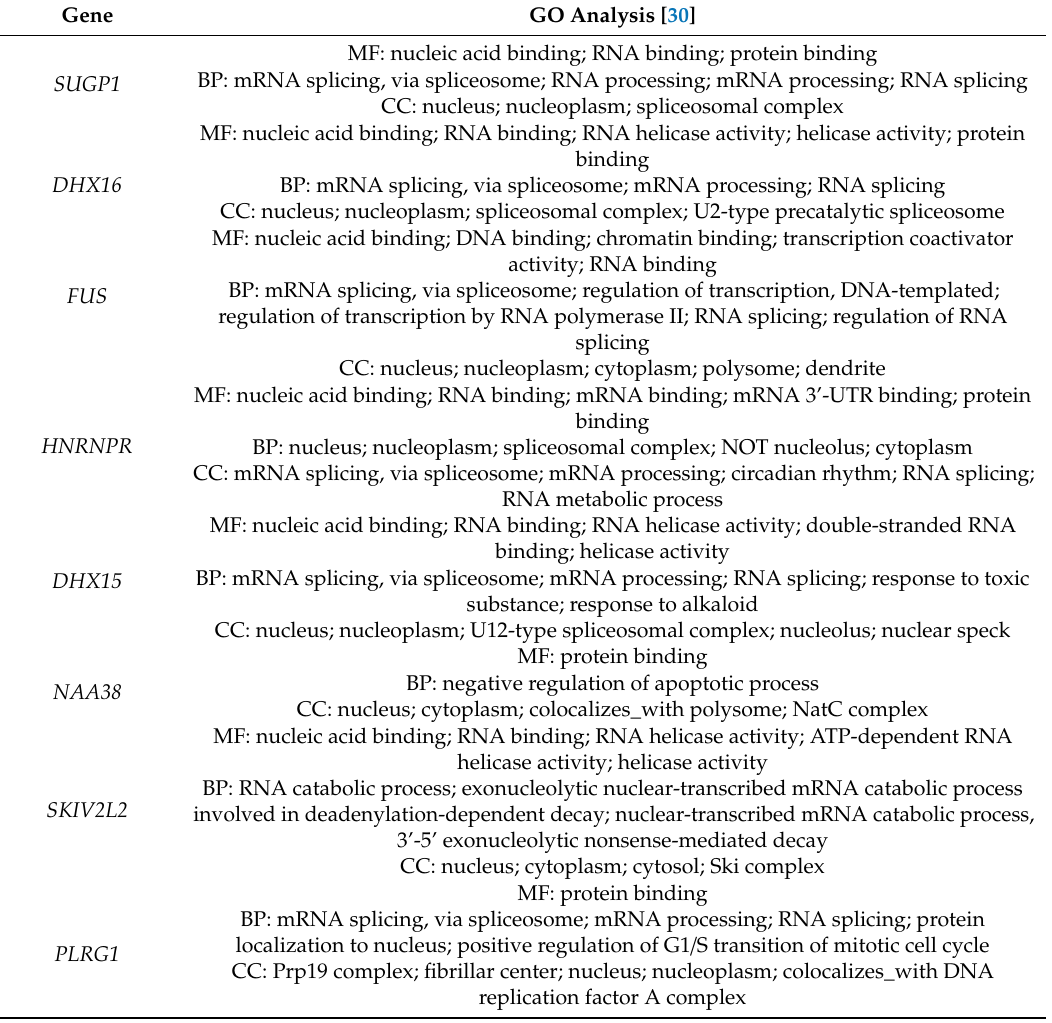
Table 7. GO analysis of hub